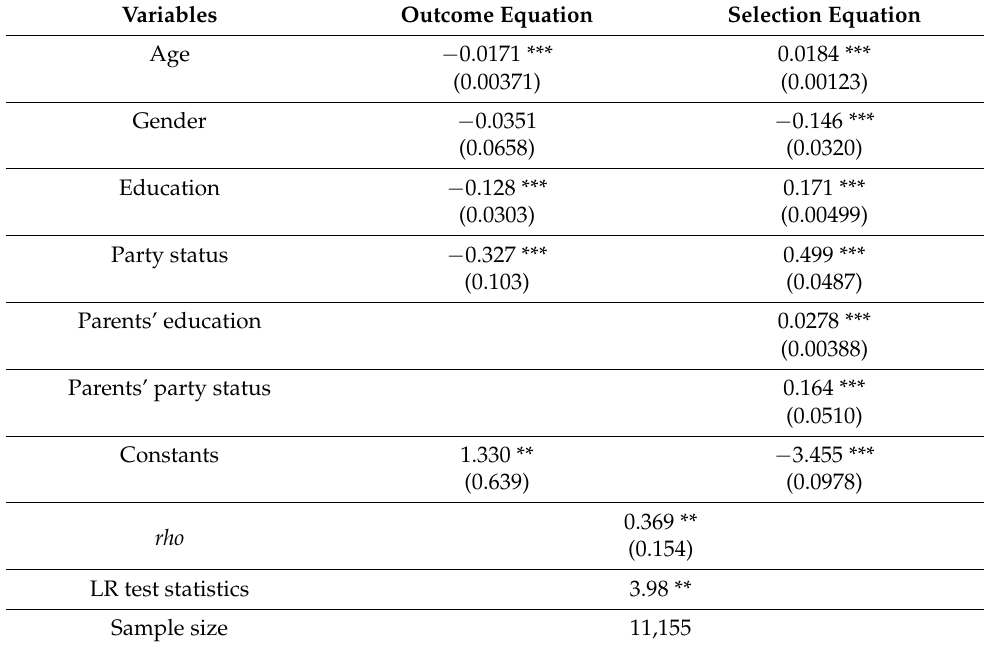
Table 2. HeckProbit model